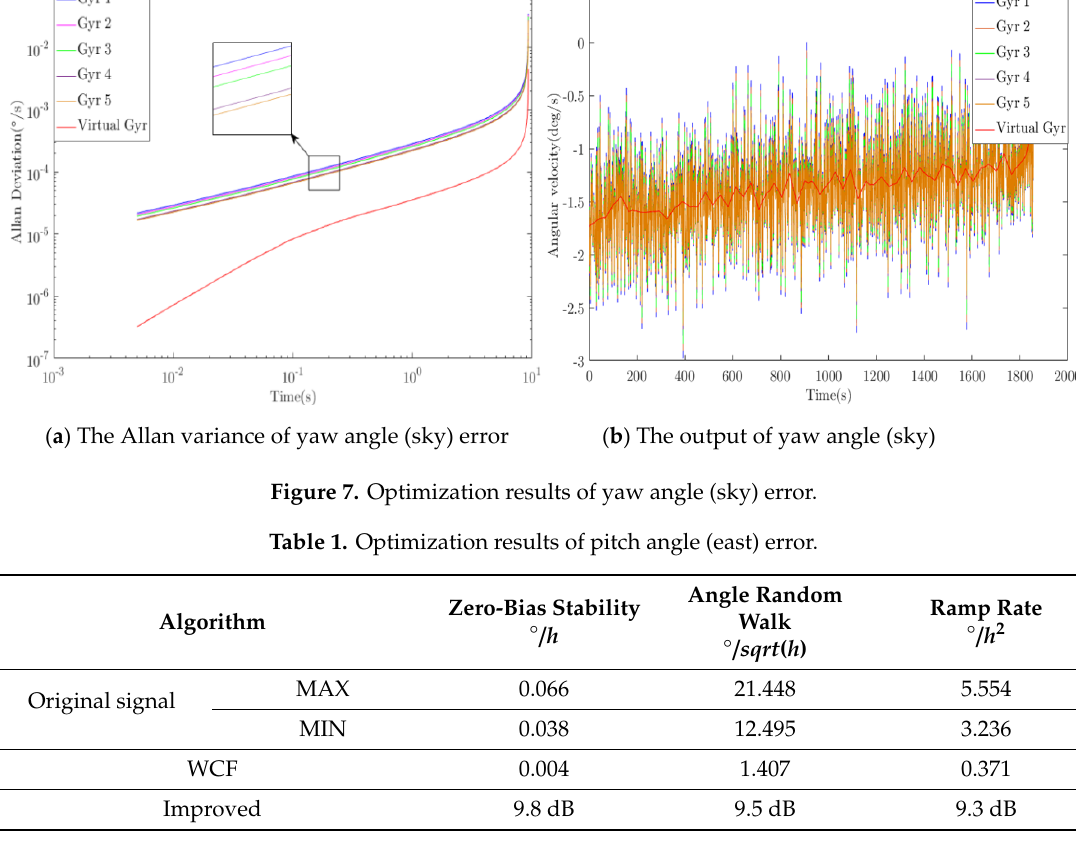
Figure 6. Optimization results of roll angle (north) error. Table 2. Optimization results of roll angle (north) error.